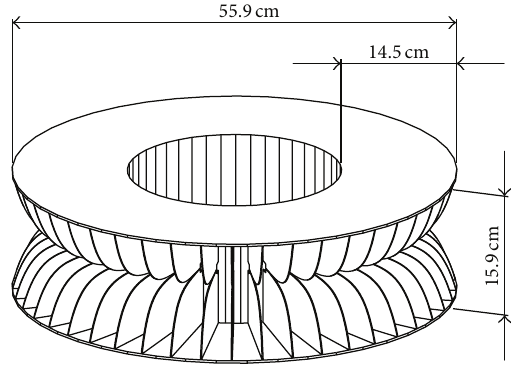
Figure 1: Simulated uniform circular array of 45 Vivaldi radiators.